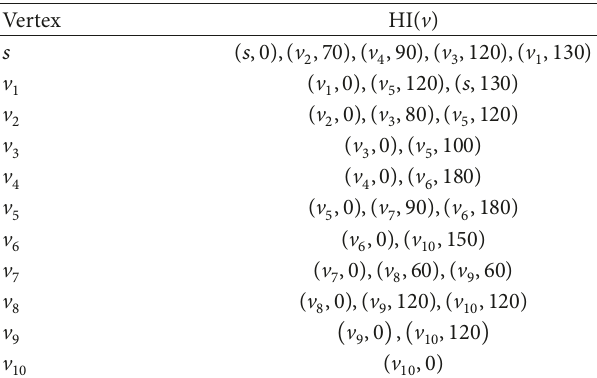
Table 4: 2-hop index